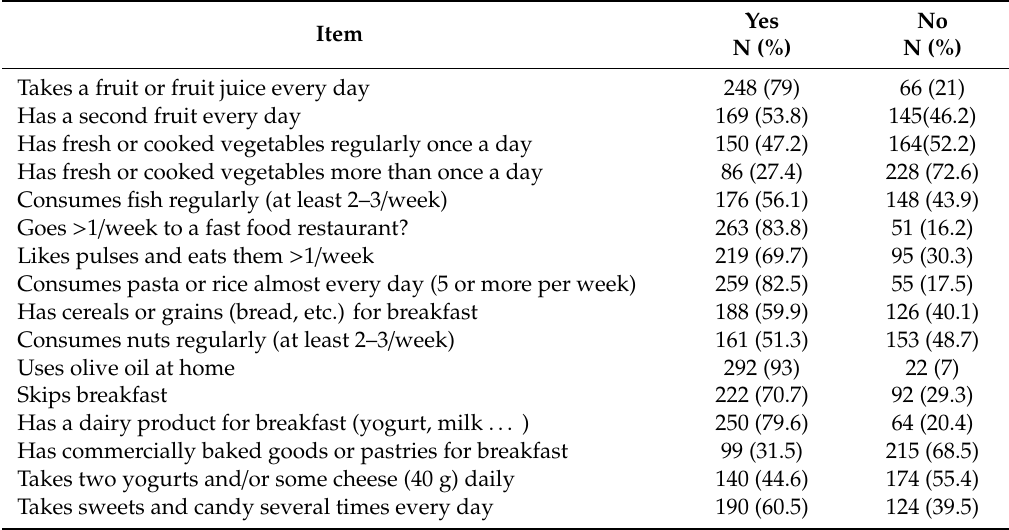
Table 2. Answers to each item of KIDMED